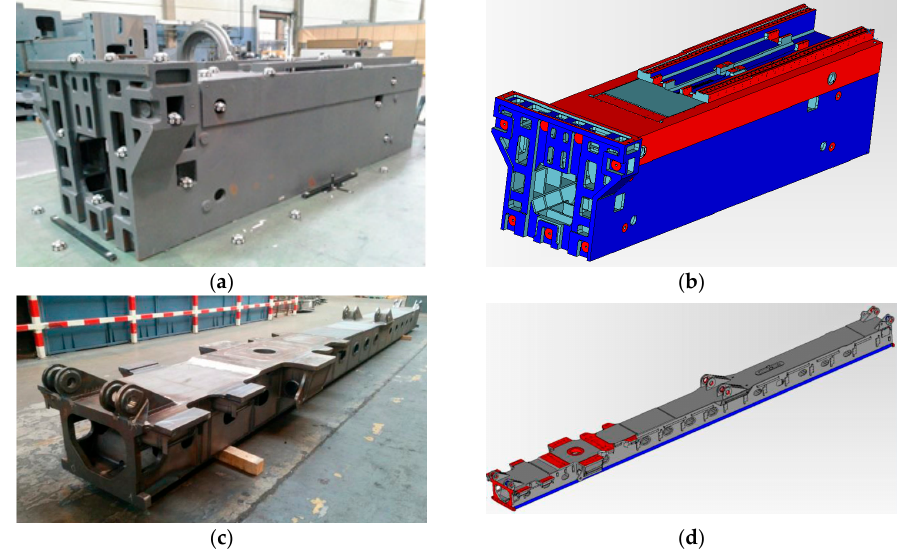
Figure 15. Evaluation tests at industrial scenarios for two end-users (Goimek and Liebherr). Large raw parts prior to their machining are shown, ( a ) Soraluce milling machine travelling column (6 m long) manufactured at Goimek machining shop, and ( c ) Liebherr drilling rig lead center (15 m long),